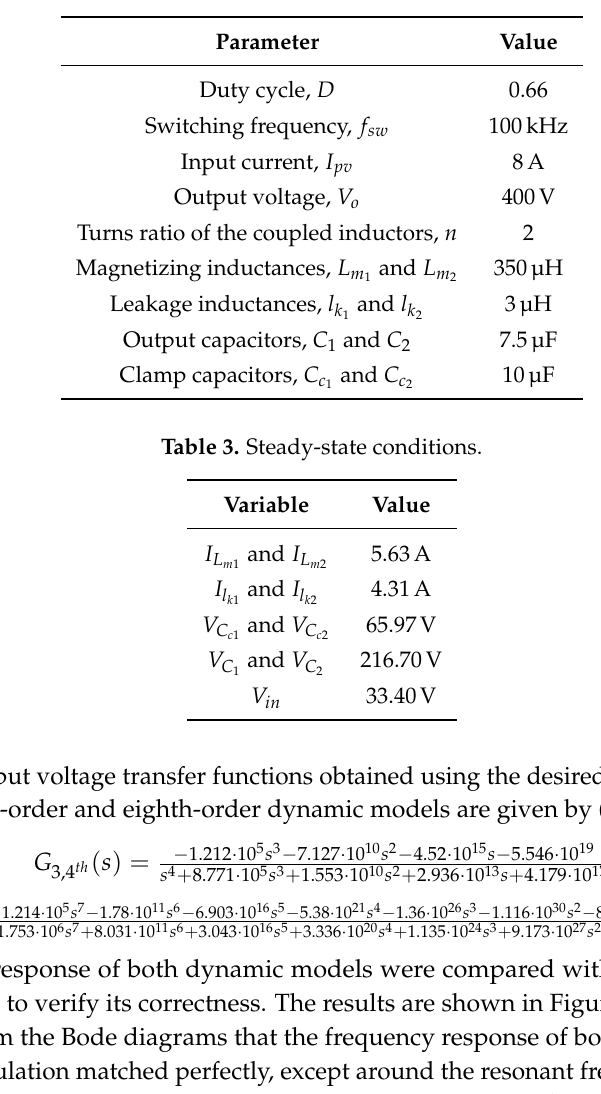
Table 2. Simulation parameters of the symmetrically-interleaved coupled inductor-based boost (SICIBB) converter.